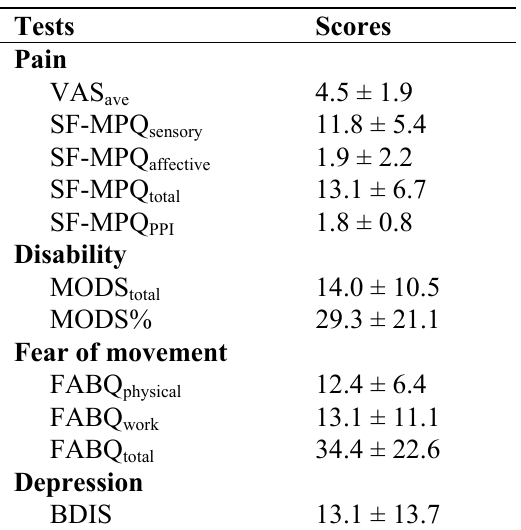
Table 1. Clinical scores (mean ± SD) in low back pain (LBP)